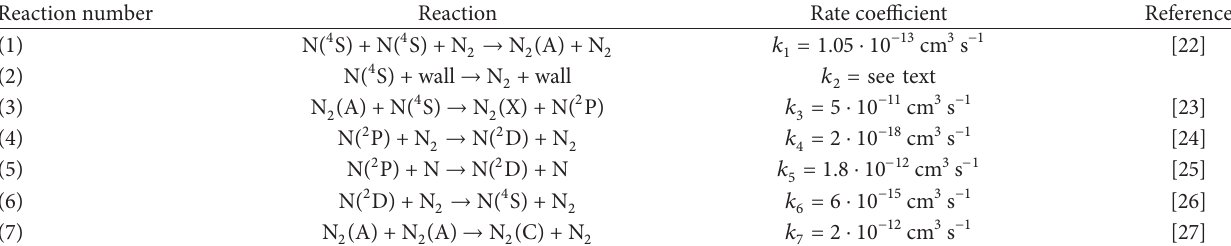
Table 1: Main plasma-chemical reactions in the pure nitrogen afterglow.